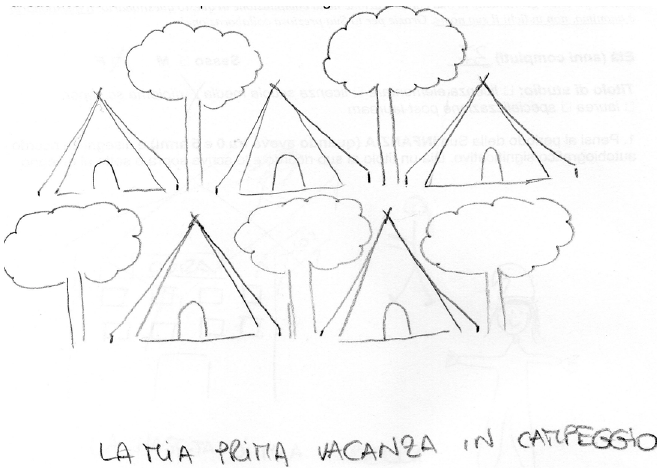
Figure 3. Drawing, referring to childhood, entitled “My first camping holiday”.